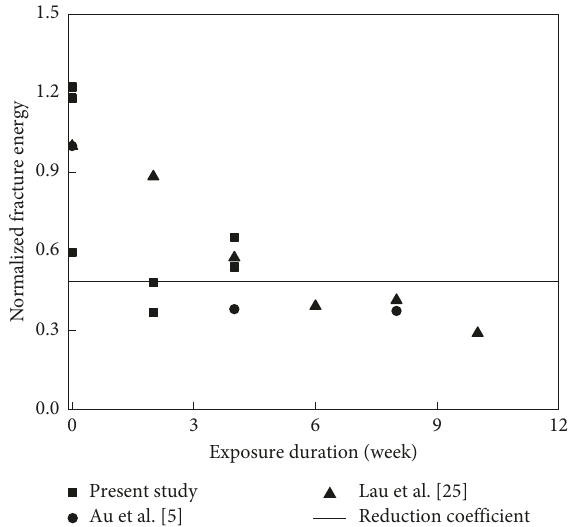
Figure 13: Disruption of the hydrogen bond.